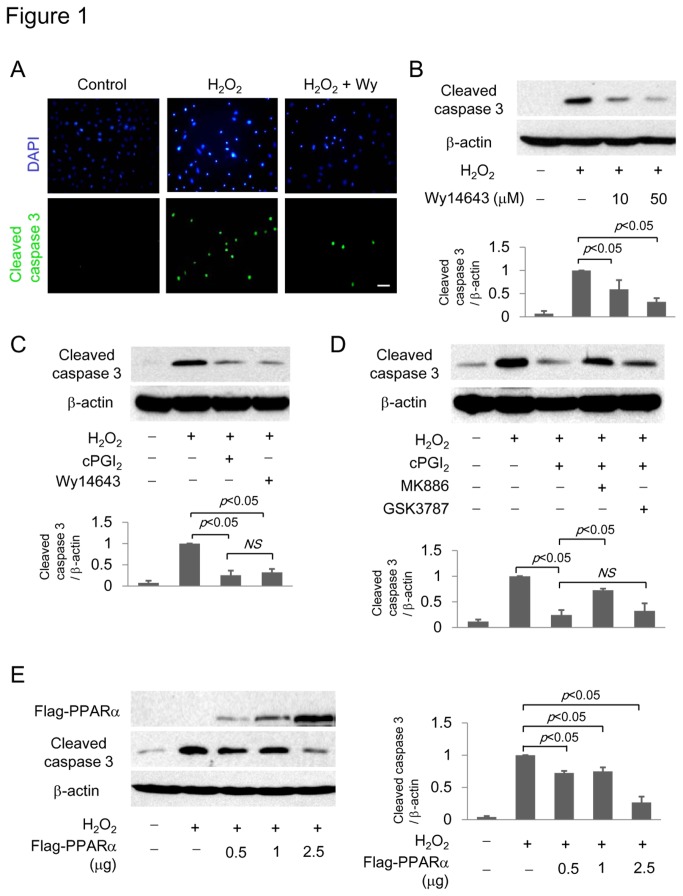
PPARα ligands attenuate H2O2-induced VSMC apoptosis.(A–C) A-10 VSMCs were pretreated with Wy14,643 (50 µM or otherwise indicated), or cPGI2 (100 µM) followed by H2O2 (0.8 mM). (A) Cells were stained with DAPI or immune-stained for cleaved caspase 3 and examined under fluorescent microscope. Scale bar = 100 µm. (B and C) Cleaved caspase 3 was analyzed by Western blotting. Upper panel shows a representative blot and the lower panel shows the quantitative analysis of densitometry of the Western Blots. (D) A-10 cells were pretreated with MK886 (25 µM) or GSK3787 (25 µM) followed by cPGI2 (100 µM) and H2O2 (0.8 mM). Upper panel shows a representative blot and the lower panel shows the quantitative analysis. (E) A-10 cells were transfected with Flag-tagged PPARα vectors at different concentrations. PPARα expression was analyzed using a Flag antibody. Cleaved caspase 3 was analyzed by Western blotting using a specific antibody. The left panel shows a representative Western blot and the right panel shows the quantitative analysis. Each error bar denotes mean±SEM and all blots are representative of n≥3. NS denotes statistically non-significant.